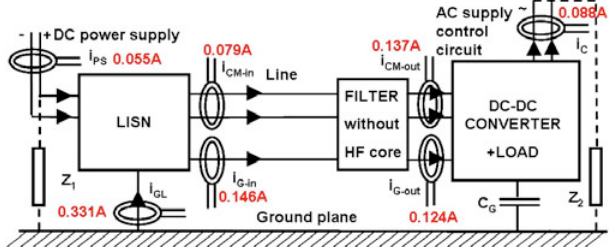
Figure 30: Maximum values of CM currents with CM and DM filter (without HF ferrite core).